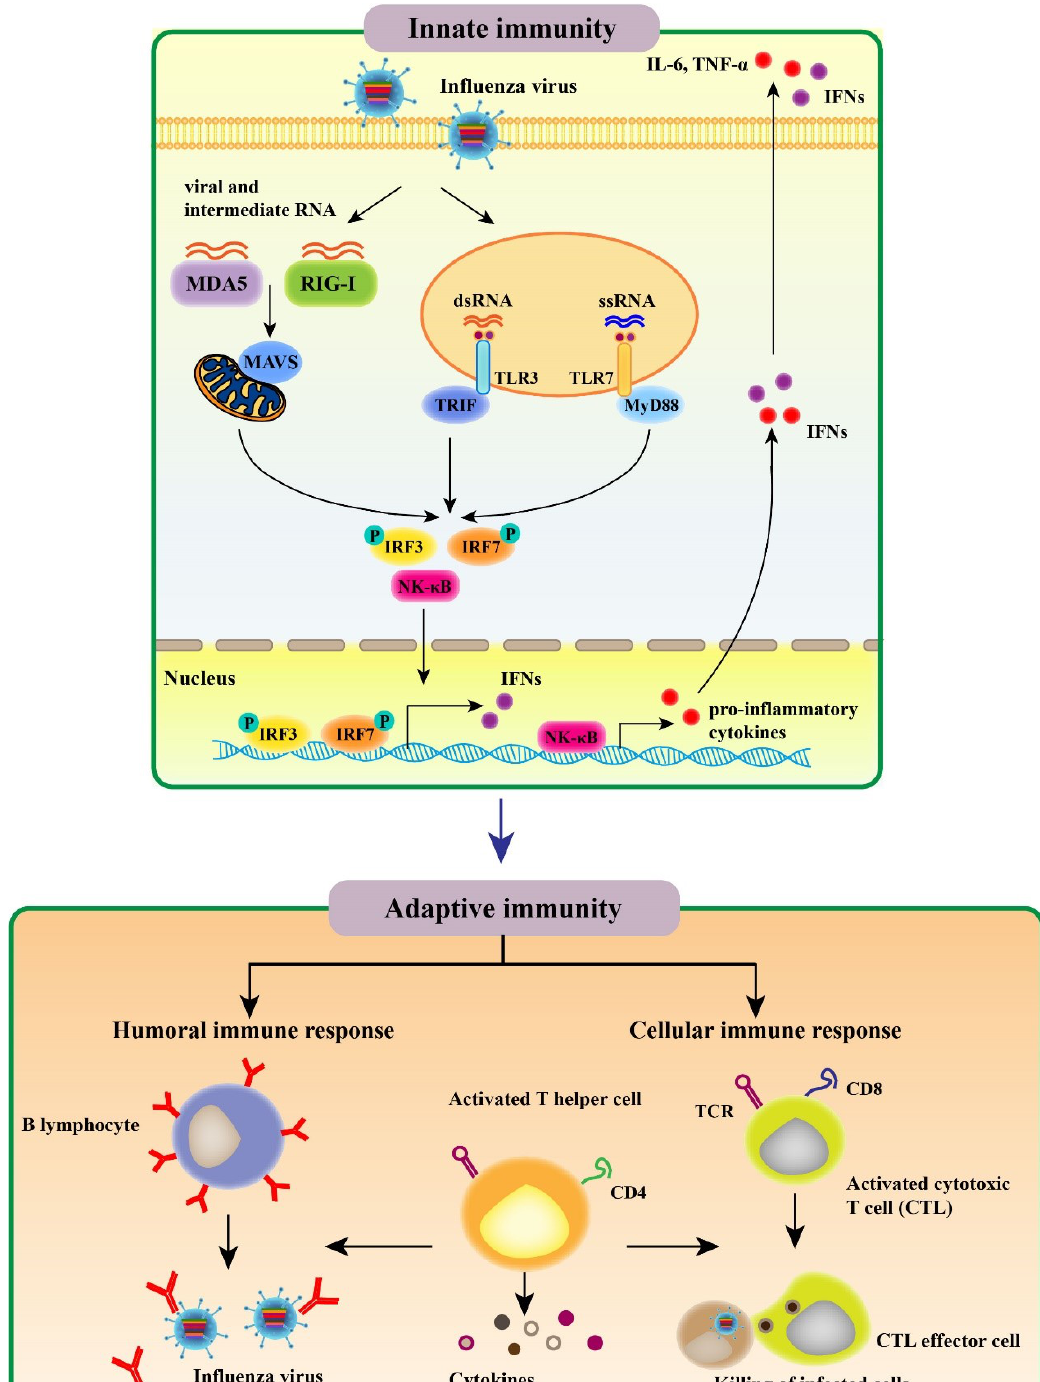
Figure 1. The innate and adaptive immunity against influenza virus.